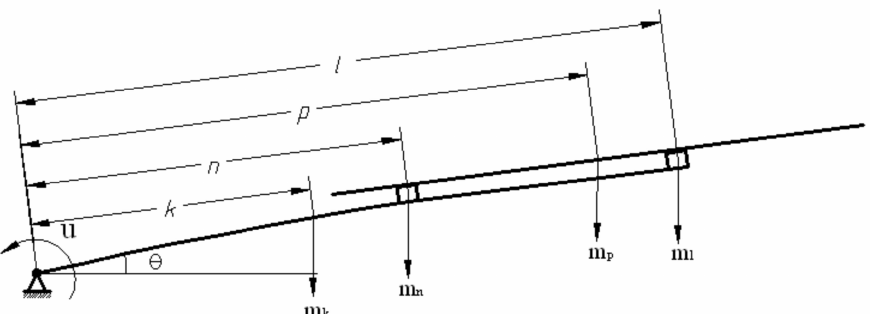
Figure 4. The locations of different parts of a mechanical